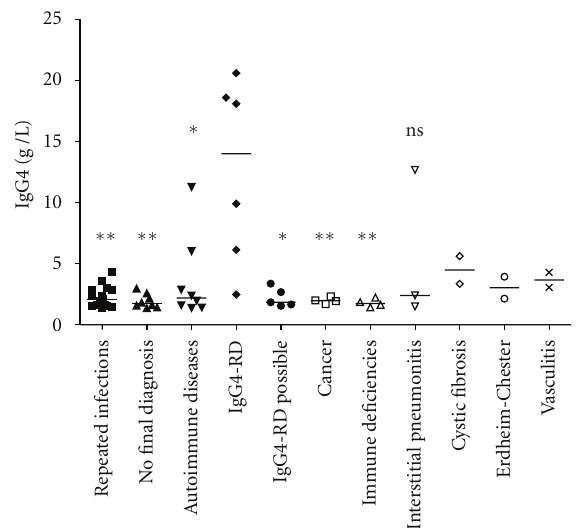
Figure 1: Serum IgG4 levels in di ff erent final diagnostic categories of patients with serum IgG4 elevation. IgG4-RD = IgG4-related disease. Horizontal bars represent median values observed in each group. Results obtained in each group were compared to results obtained in IgG4-RD group (Mann-Whitney test): ∗∗ P < 0 . 005; ∗ P < 0 . 05; ns: not